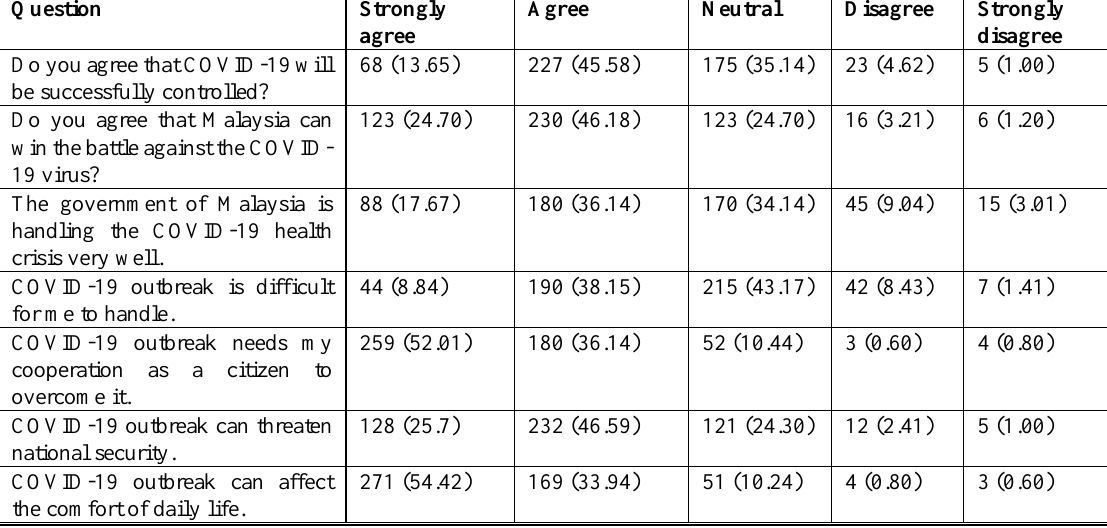
Table 6. Attitudes and perceptions of students toward learning during COVID-19